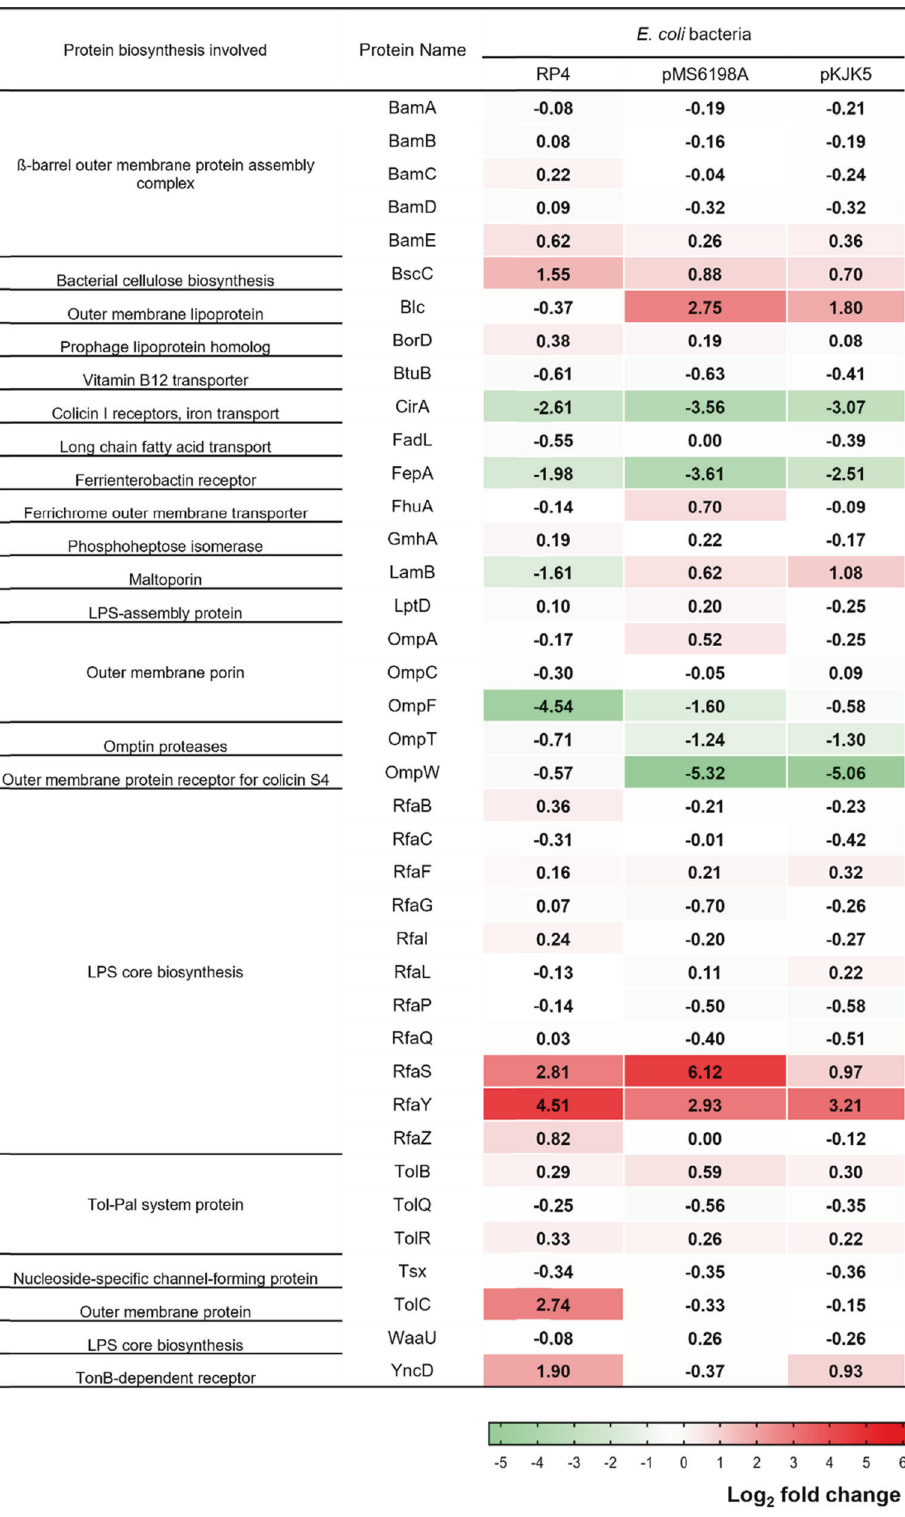
Fig. 4 Log 2 fold change of membrane proteins of E. coli K12 bacteria harbouring different plasmids in comparison to E. coli K12 wild type (no plasmid). RP4 represents E. coli K12 harbouring plasmid RP4; pMS6198A represents E. coli K12 harbouring plasmid pMS6198A; pKJK5 represents E. coli K12 bacteria harbouring plasmid